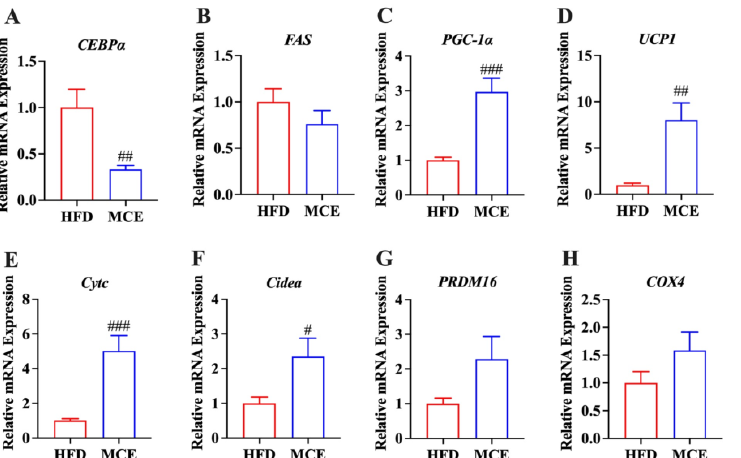
Figure 3. MCE alters the expression of genes related to adipogenesis and thermogenesis in epididymal WAT. The expression of ( A – C ) adipogenesis and ( D – H ) thermogenic genes in the epididymal adipose tissues of mice. CCAAT/enhancer binding-protein α ( C/EBP α ). Fatty acid synthase ( FAS ). Peroxisome proliferator-activated receptor gamma coactivator 1-alpha ( PGC-1 α ). Uncoupling protein 1 ( UCP1 ). Cytochrome c ( Cytc ). Cell death activator CIDE-A ( Cidea ). PR domain containing 16 ( PRDM16 ). Cytochrome c oxidase subunit 4 ( COX4 ). # p < 0.05 versus HFD group, ## p < 0.01 versus HFD group, ### p < 0.001 versus HFD group.